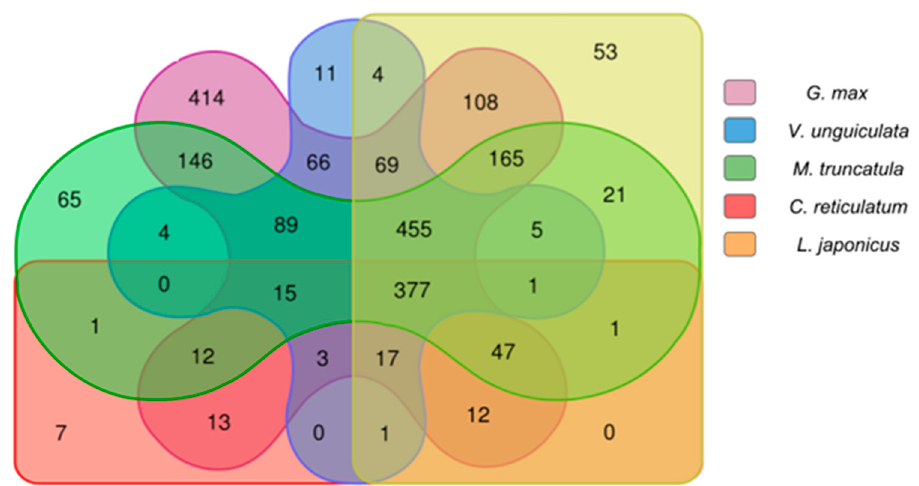
Figure 4. Count of copa í ba lncRNAs aligned to each Fabaceae transcriptome with BLASTN (50% identity): This diagram shows the amount of copa í ba lncRNA aligned to the transcriptome of each species, segregated by a color pattern indicated on the legend. In the colored overlapped area are the transcripts which were aligned to more than one species transcriptome, and its respective amount. There are only five species shown in this diagram, for illustration purposes we left out P . vulgaris .